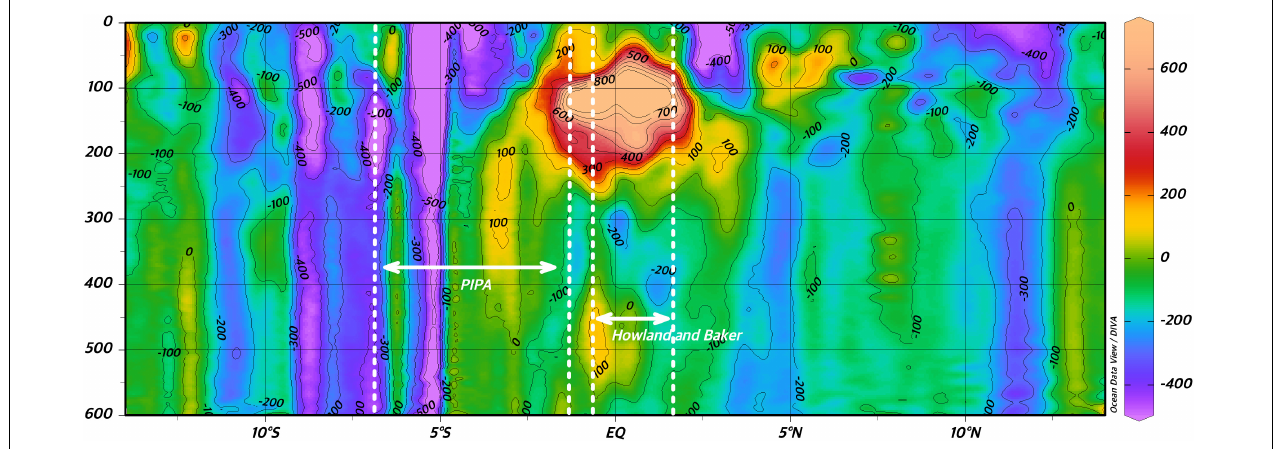
FIGURE 3 | Acoustic Doppler Current Profiler measurement of the east component of equatorial currents at the latitudes of PIPA and Howland and Baker (north/south boundaries indicated with dotted lines). The complex system of east- and west-flowing currents and countercurrents include the Equatorial Undercurrent (EUC), North Equatorial Countercurrent (NECC), North and South Equatorial Currents (NEC, SEC, and respectively), and the North and South Deep Countercurrents (NDCC, SDCC, and respectively). Positive (warm colors) values are east flowing currents, negative (cold colors) denote westerly flow. Data were collected in July/August of 2016 on a north to south transect with mean longitude of –166 ◦ E.